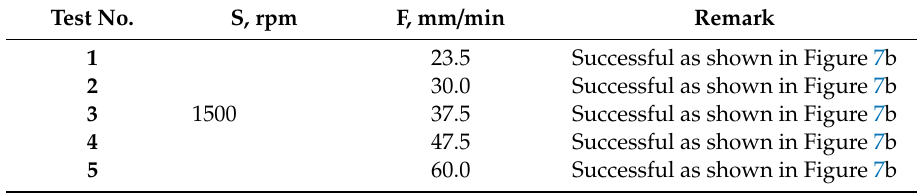
Table 5. Experimental conditions employed to fabricate Cu 1-1060Al lap joints using HSCo square-pin tool (T D : 22 s). Test No.